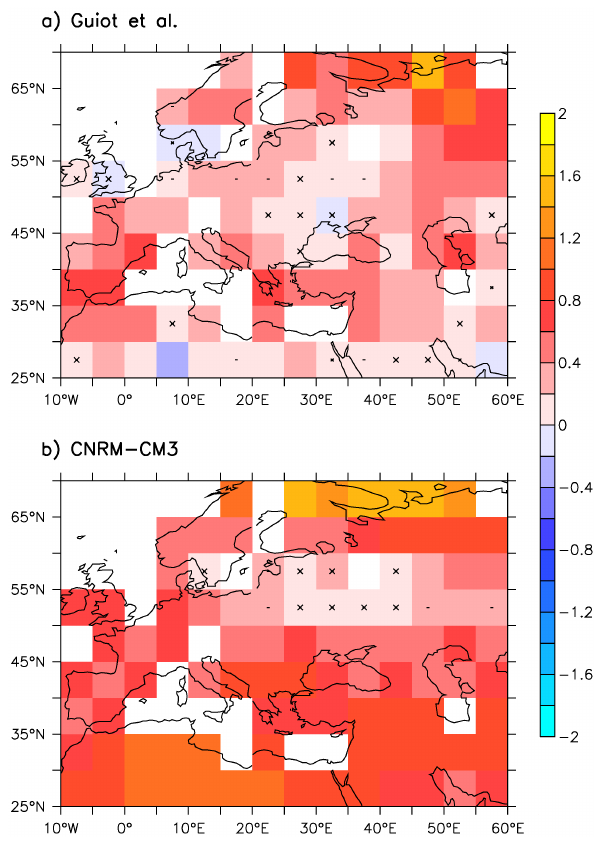
Fig. 2. (a) Spatial regression of the summer temperature from Guiot Figure 2. a Spatial regression of the summer temperature from Guiot et al. (2010) on the solar 2 et al. (2010) on the solar variations (in ◦ C/Wm − 2 ) for the period variations (in °C/W.m -2 ) for the period 1001-1860. The large black crosses indicate the point 3 1001–1860. The large black crosses indicate the point not signifi- not significant at the 90%, the smaller one, the region not significant at the 95% and the 4 cant at 90%, the smaller one, the region not significant at 95% and the horizontal line at the 99% level. (b) same as (a) but for the sim- horizontal line at the 99% level. b Same as a but for the simulation (note that the ocean point 5 ulation (note that the ocean point have been excluded since the data have been excluded since the data used by Guiot et al. (2010) are from land). 6 used by Guiot et al., 2010 are from